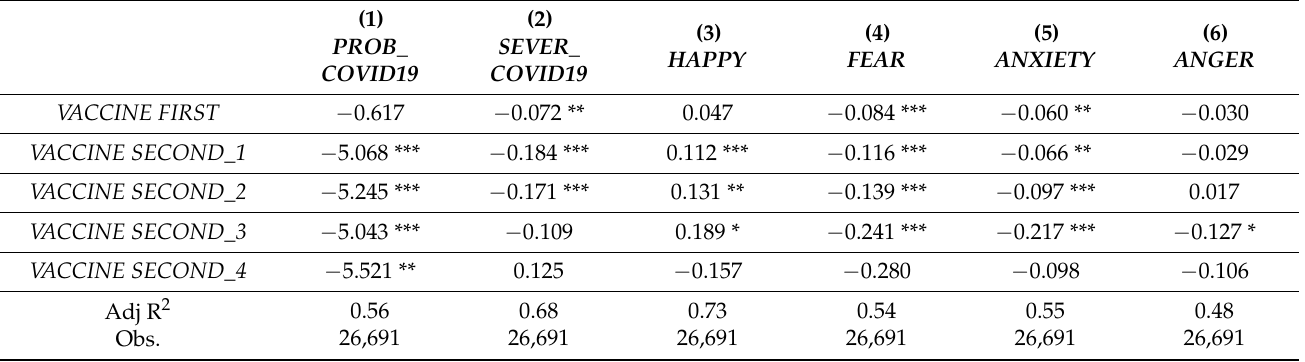
Table 6. FE model: Dependent variables are perceptions of COVID-19 and mental health. Female